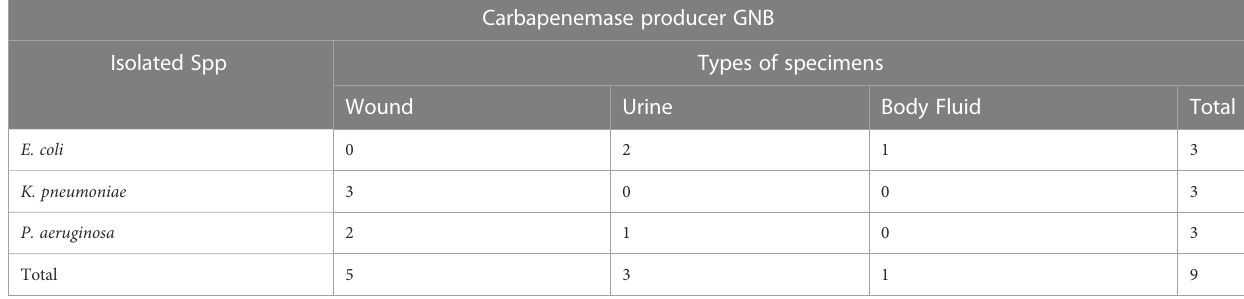
TABLE 7 Distribution of carbapenemase producing gram negative bacteria against isolated species and specimen types.